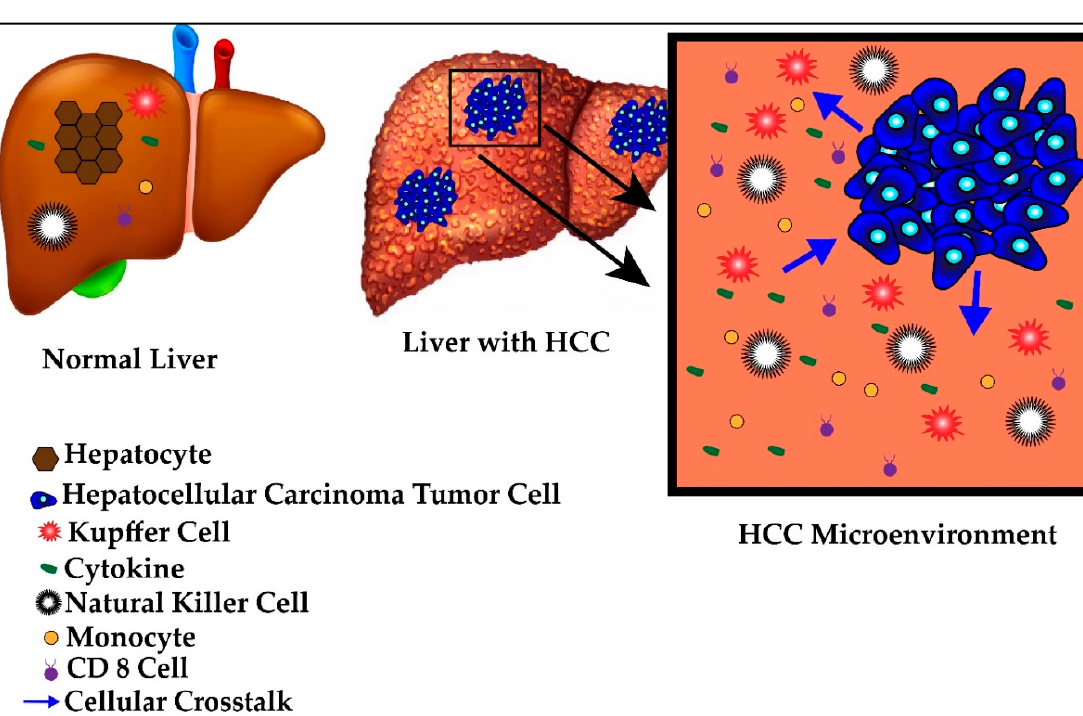
Figure 2. Normal versus hepatocellular carcinoma (HCC) microenvironment.